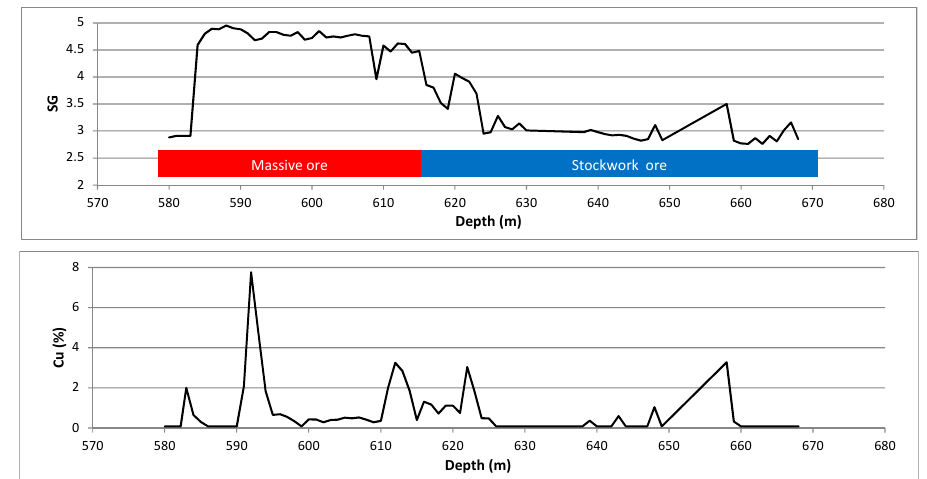
Figure 1. Specific gravity (SG) and Cu grades along the depth of one borehole intersecting the entire Zambujal deposit.